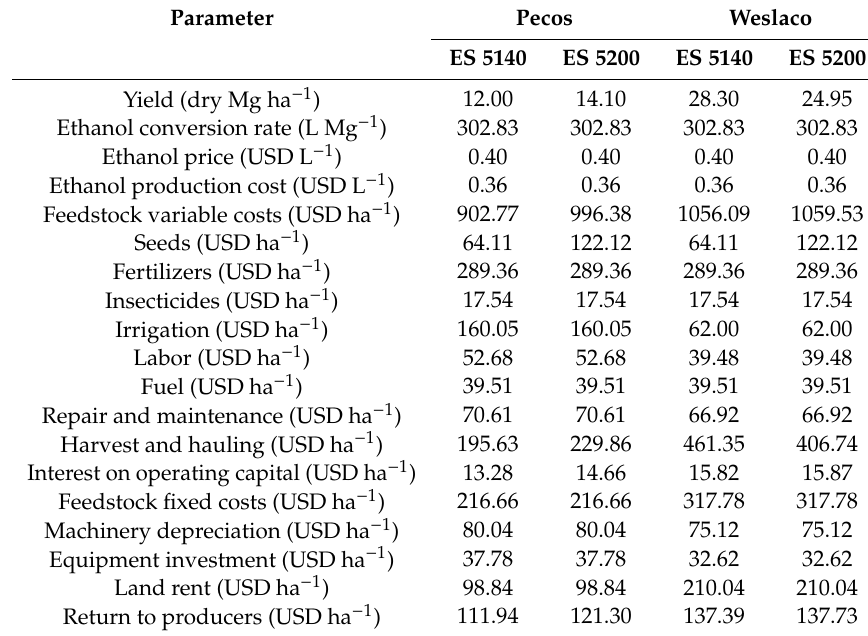
Table 4. Parameters used in the economic